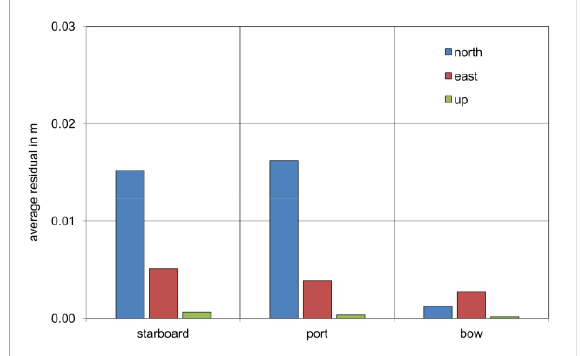
Figure 5. Average absolute residuals of transformation of ship frame coordinates of GNSS antennas to GNSS- derived 3D co- ordinate differences in